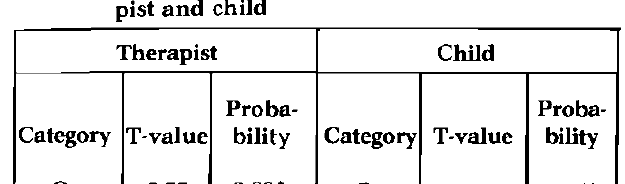
Table 5: Significant differences in means with respect to the functional categories used by the thera- pist and